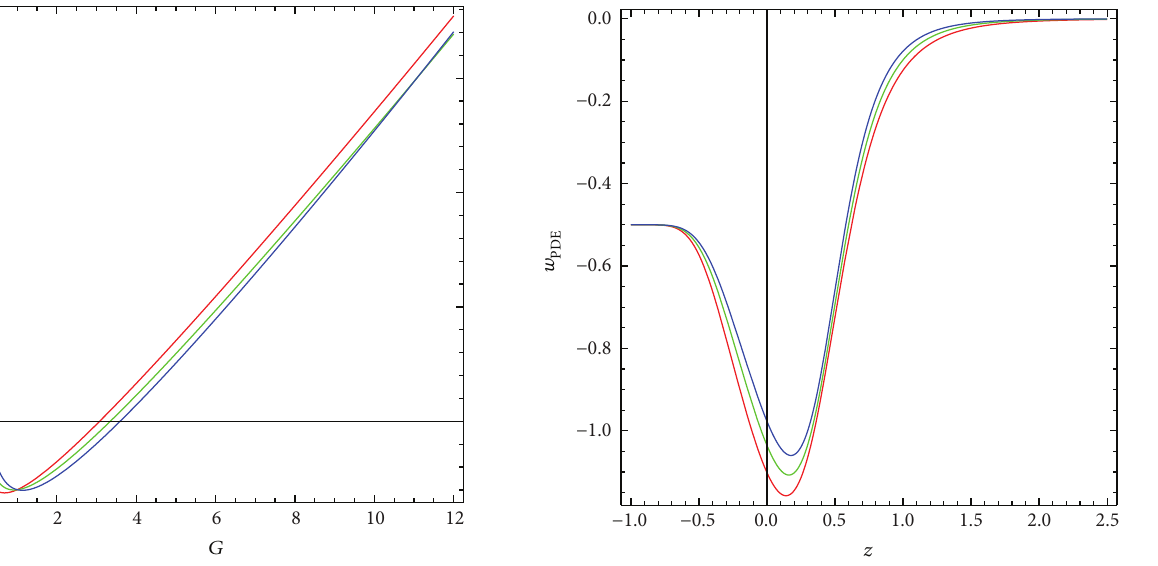
0.0 Figure 2: Plot of 𝑓(𝐺) versus 𝐺 for PDE parameter 𝑢 = −2 with 𝑚 = 2 (red), 𝑚 = 2.2 (green), and 𝑚 = 2.4 (blue).